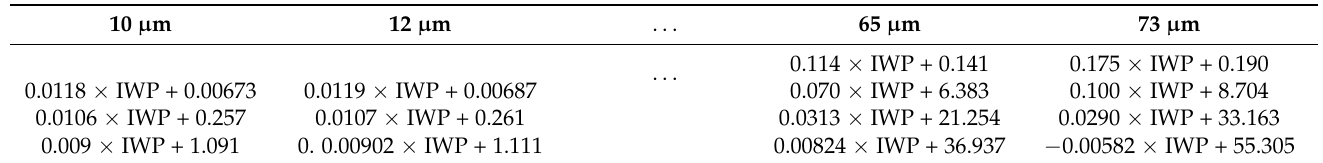
Table 1. The fitted piecewise functions of IWP and brightness temperature depression at 664.0 ± 4.2 GHz, the table header is labeled D me for each piecewise function.